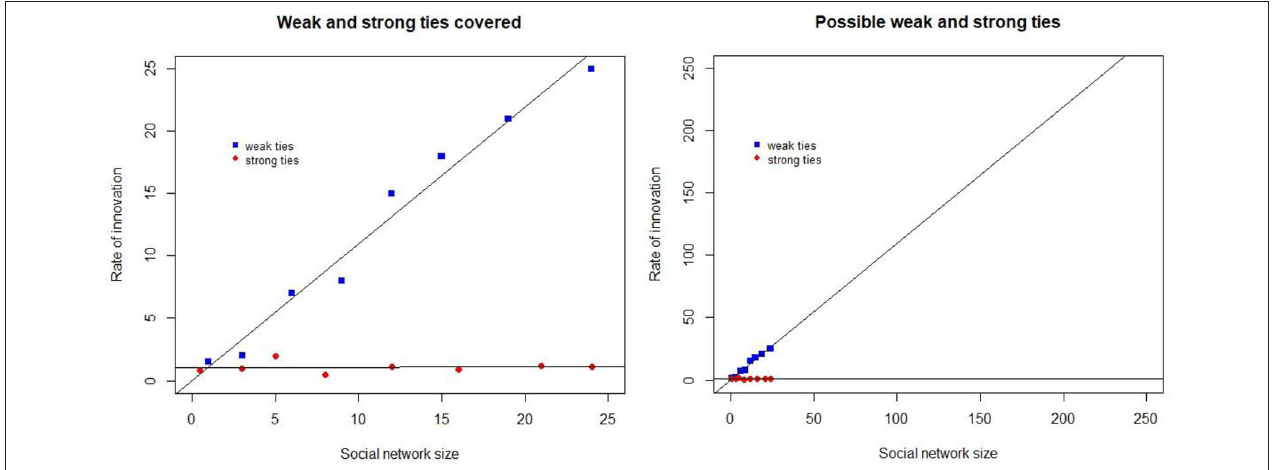
FIGURE 1 | A schematic representation of the network sizes covered ( Left ) and also the cognitively possible networks ( Right